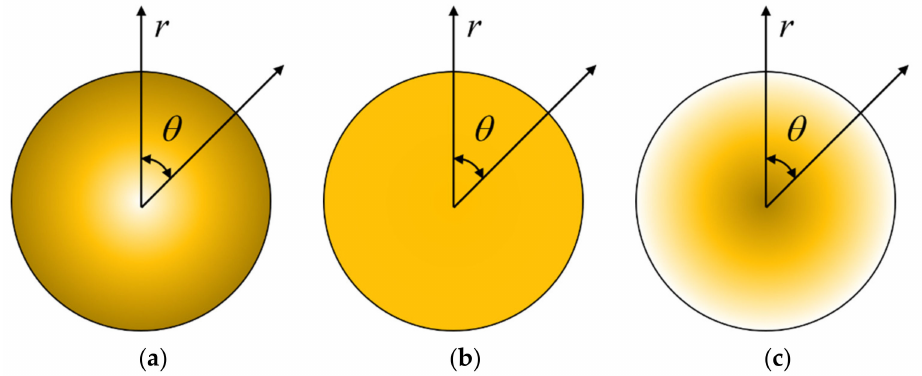
Figure 2. GPL distribution patterns for the microbeam. ( a ) Pattern X; ( b ) Pattern U; ( c ) Pattern O. According to the mixing rule, the mass density ( ρ B ) and Poisson’s ratio along ( ρ B )